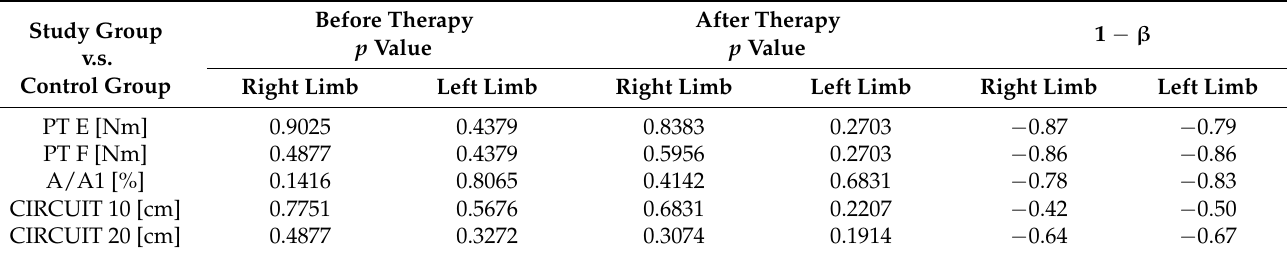
Table 4. Comparison of the results recorded in the study and control groups before and after the therapy. Study Group